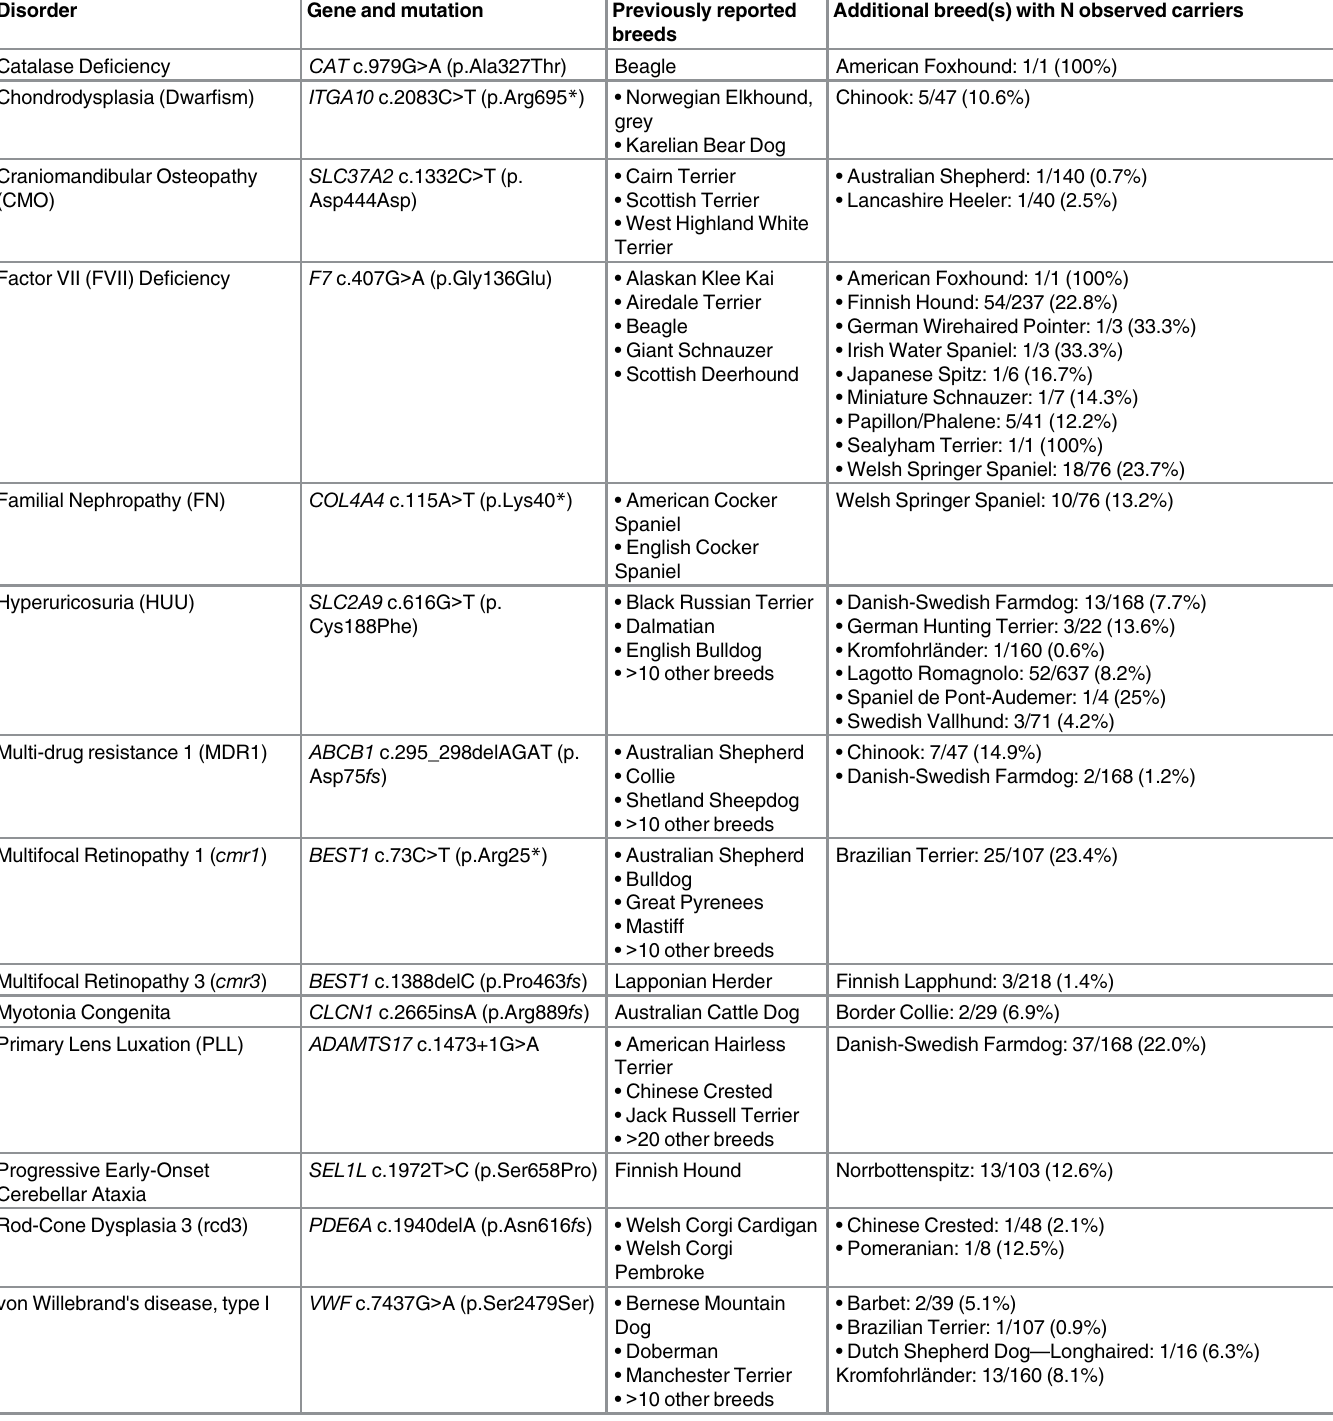
Table 1. Summary of disease variant findings in additional